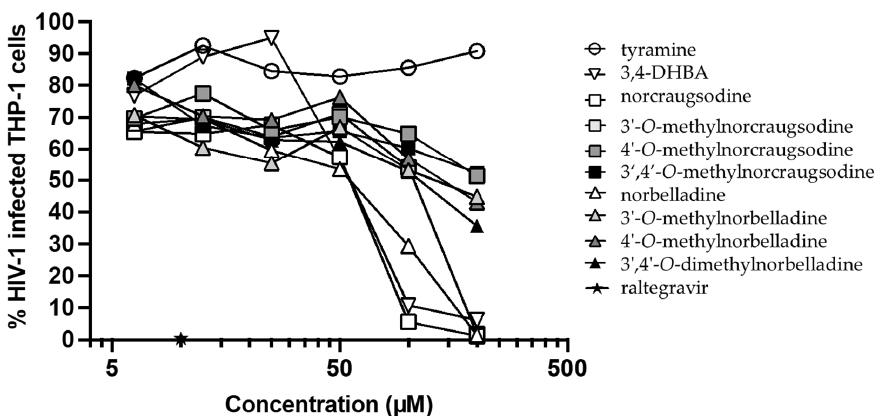
Figure 3. Antiretroviral effect of norbelladine precursors and derivatives on HIV-1 GFP . The antiviral activities against HIV-1 GFP of norbelladine precursors and derivatives were evaluated 72 h post-infection using THP-1 cells via flow cytometry at concentrations ranging from 6.25 μ M to 200 μ M. Infections were performed with non-propagative HIV-1 GFP virus at a multiplicity of infection (MOI) of 0.1. Raltegravir served as a positive control and DMSO as a negative control at concentrations equivalent to the tested alkaloids. Results were normalized to the value with HIV-1 GFP infection without treatment and the x -axis is displayed as log 10.